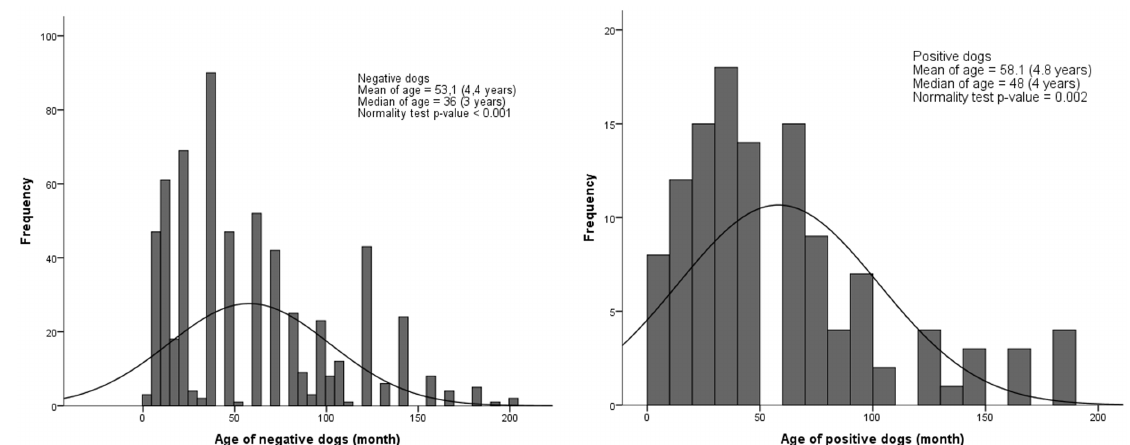
Fig 2. Histogram of age for positive and negative dogs for T . gondii serology in the urban area of Londrina, from July 2015 to July 2016.